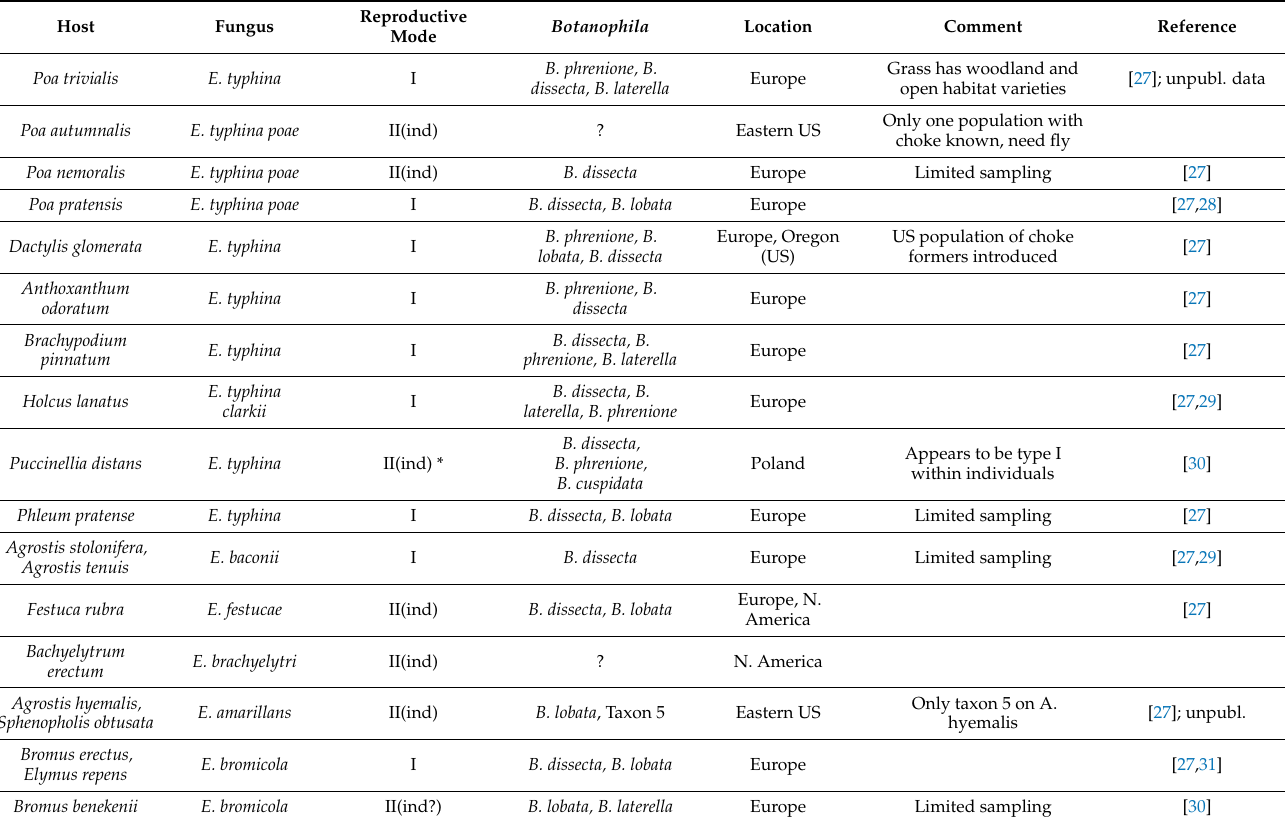
Table 1. Host plant, Epichloë and Botanophila associations with respect to reproductive mode of Epichloë. * Individuals of these fungi have been found that are type I, type II, or type